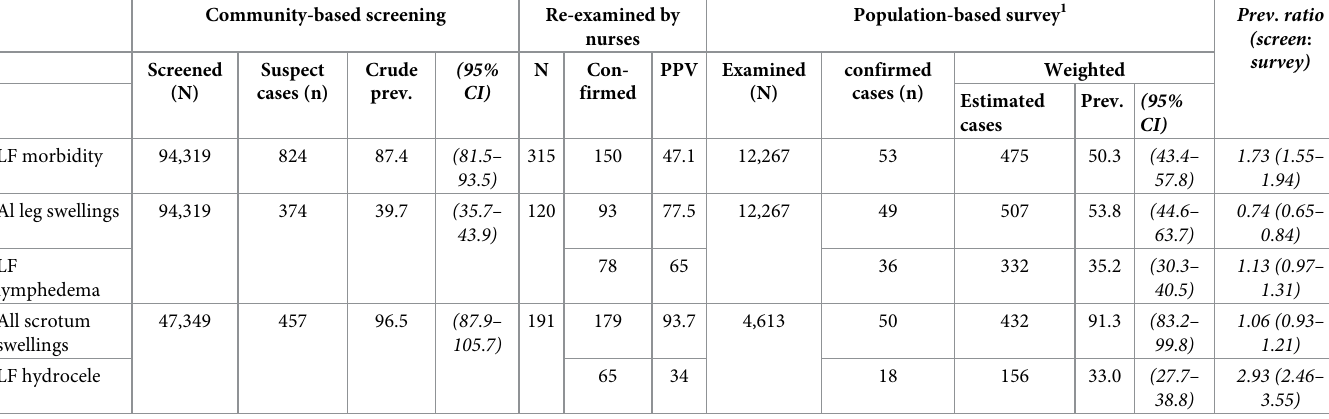
Table 2. Number and prevalence (per 10,000) of LFM cases detected through community-based screening and population-based survey. Community-based